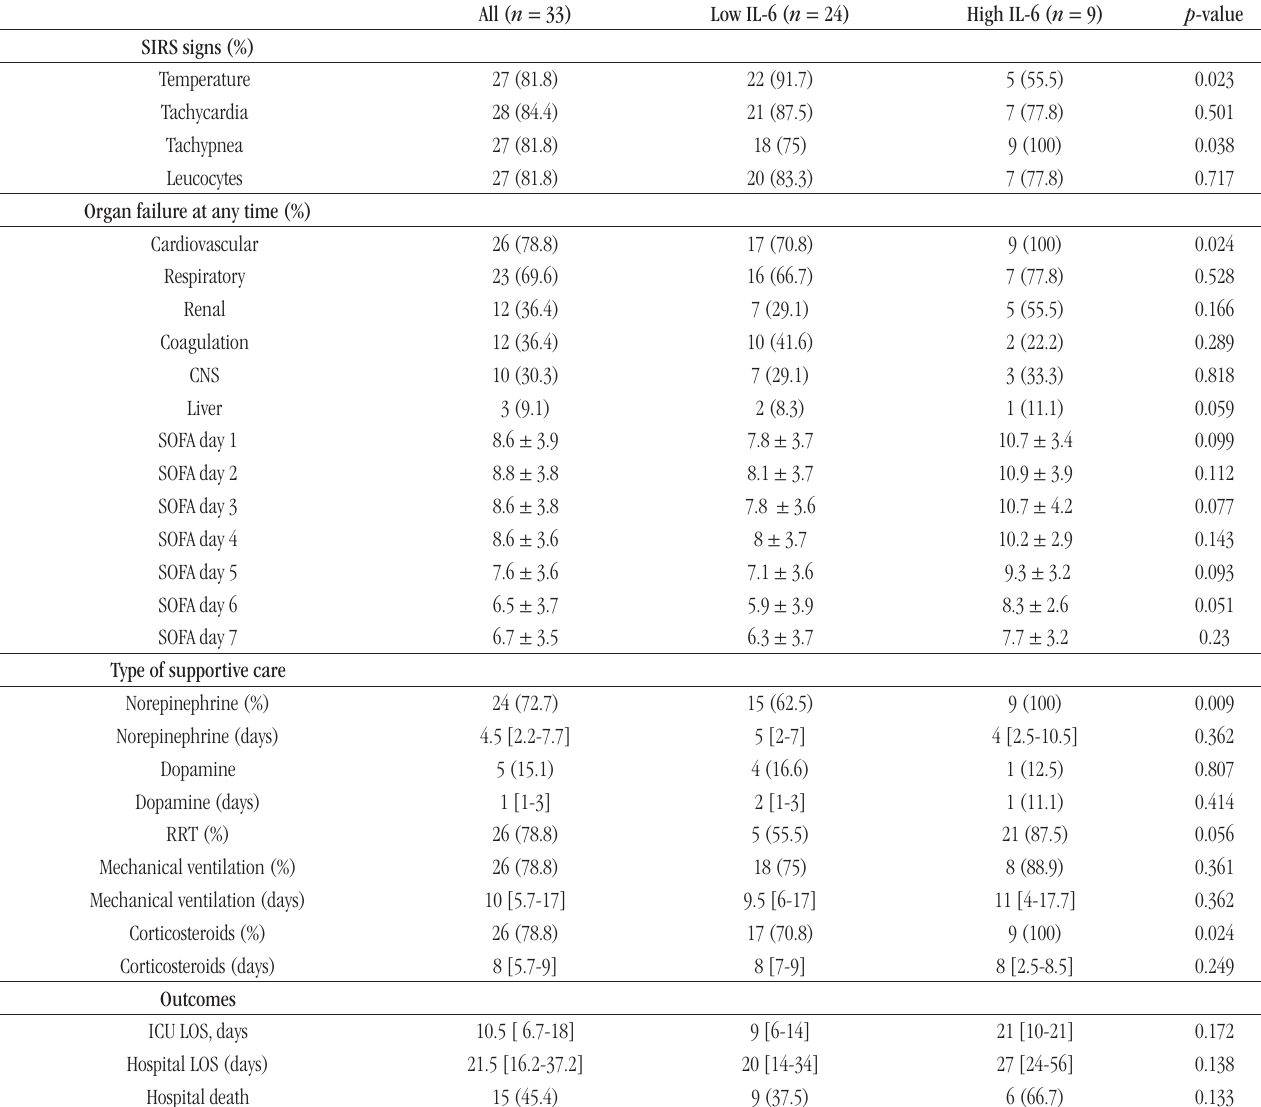
taBLE 2 − SIRS signs, organ failure, and therapeutic support measures in patients with Low and High IL-6 All ( n = 33) Low IL-6 ( n = 24) High IL-6 ( n =